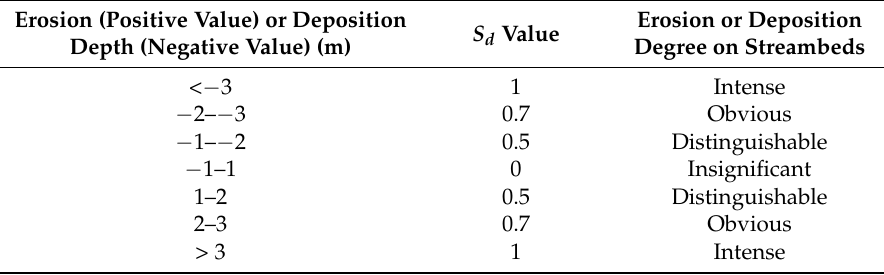
Table 1. S d for erosion and deposition depth on